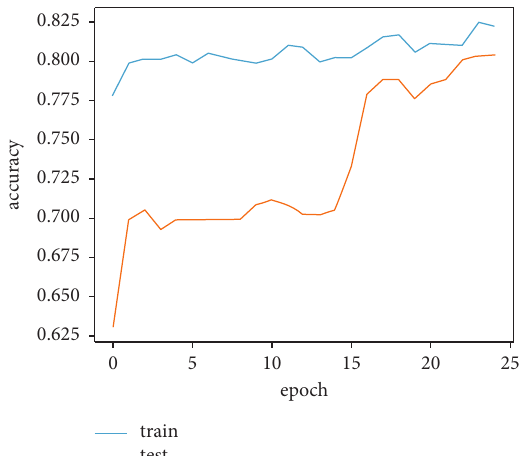
Figure 8: AlexNet.